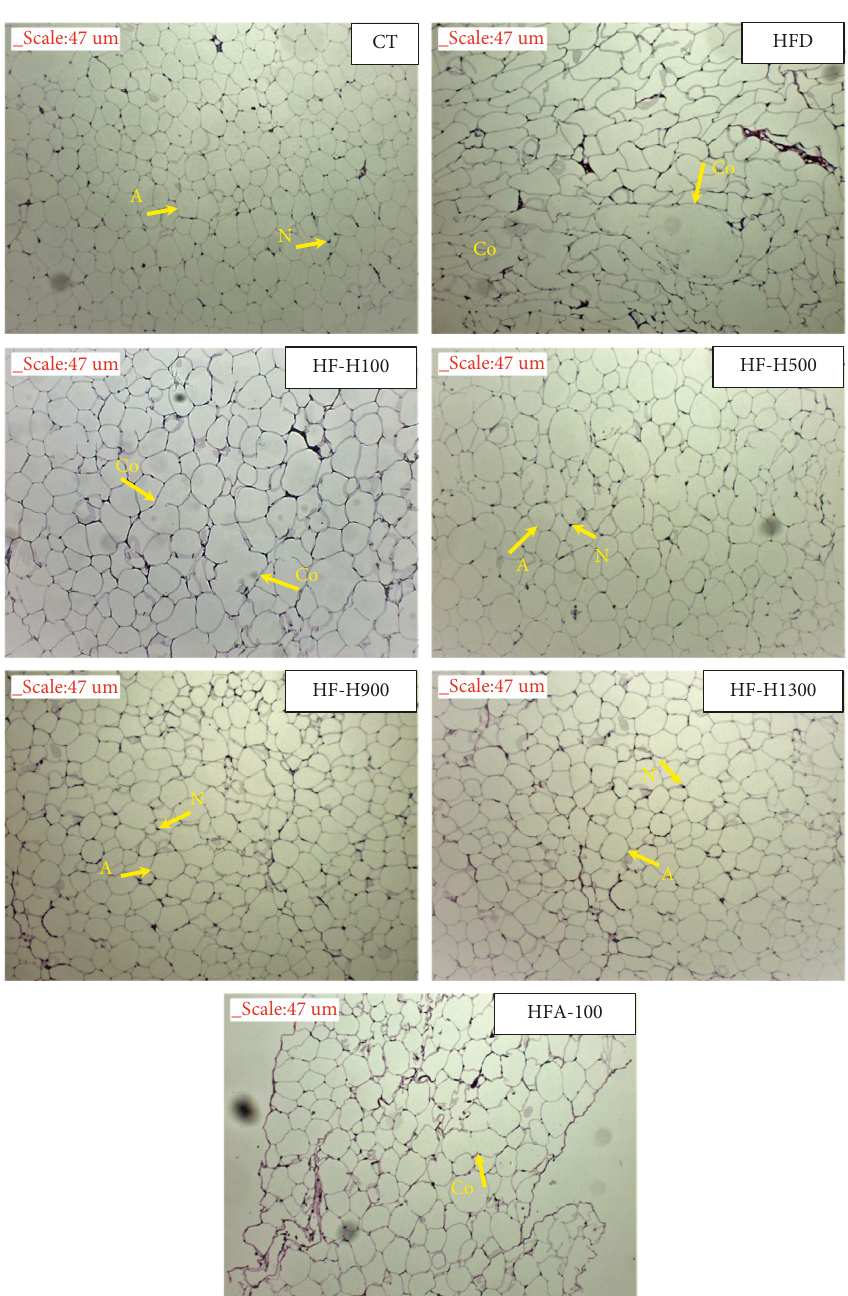
Figure 5: Photomicrographs of white adipose tissue (A: adipocytes; Co: coalescence; and N: